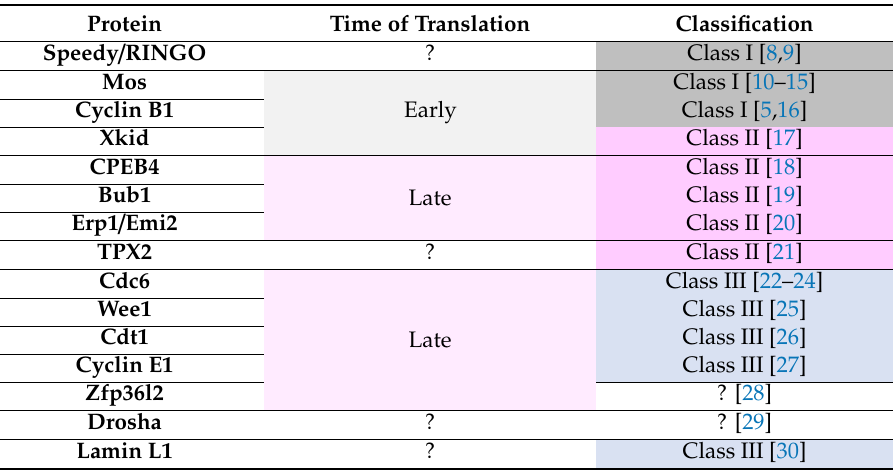
Table 1. Temporal and functional classification of proteins during meiosis. Summary of the known proteins that accumulate during meiosis before (early) or after (late) NEDB. Class I proteins are involved in Cdk1 activation. Class II proteins are important for meiosis progression, and Class III proteins support embryo